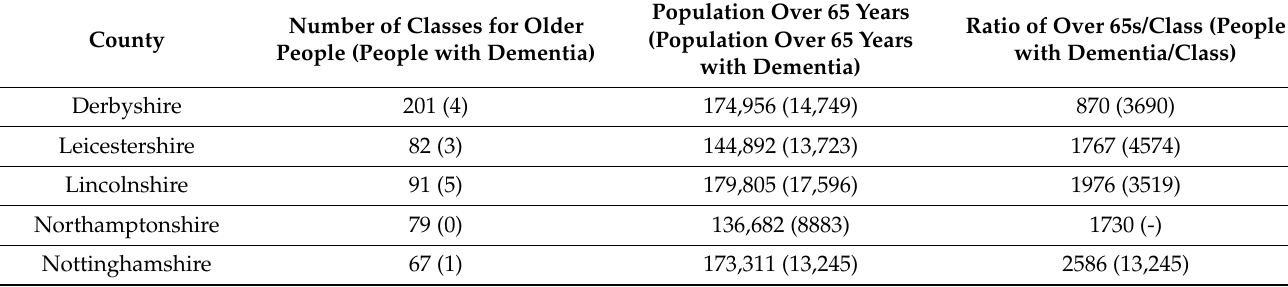
Table 1. Number of classes and population over 65 years.